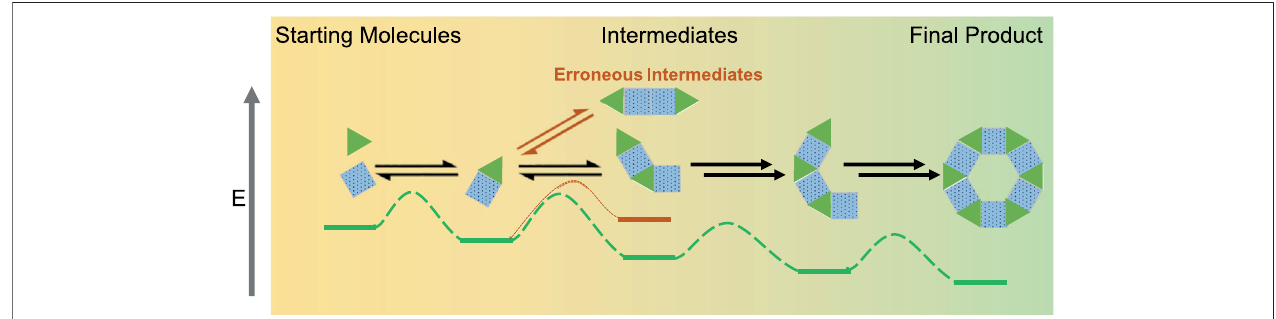
FIGURE 1 | Simpli fi ed example of the self-assembly of Starting “ building block ” Molecules into Final “ assembled ” Product through repeated association and dissociation events that produce intermediates, erroneous intermediates, and side products. Note that each step of self-assembly is reversible, and therefore the entire process is in dynamic equilibrium (Whitelam and Jack, 2015).